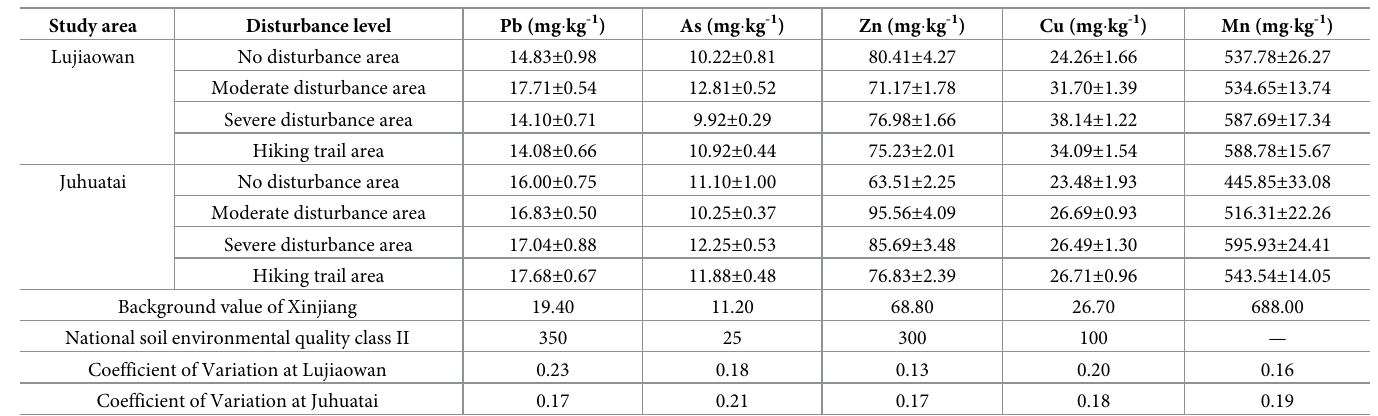
Table 6. Heavy metal concentration in soils of study area.